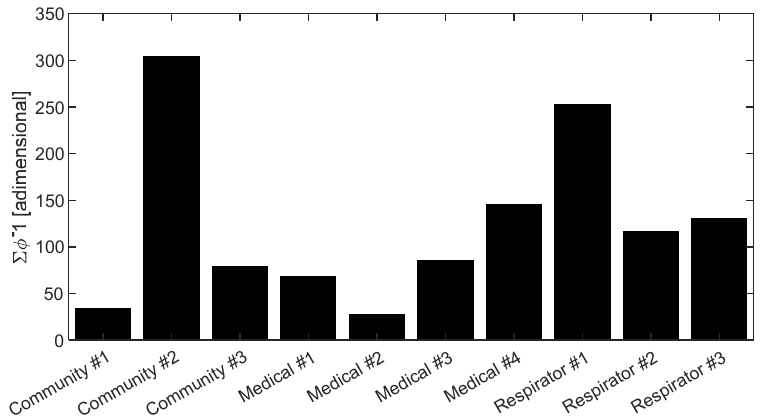
Figure 12. Plot of the sum of the inverse of porosity, ϕ (percentage of void/ total area), for the dif- ferent layers of each mask.